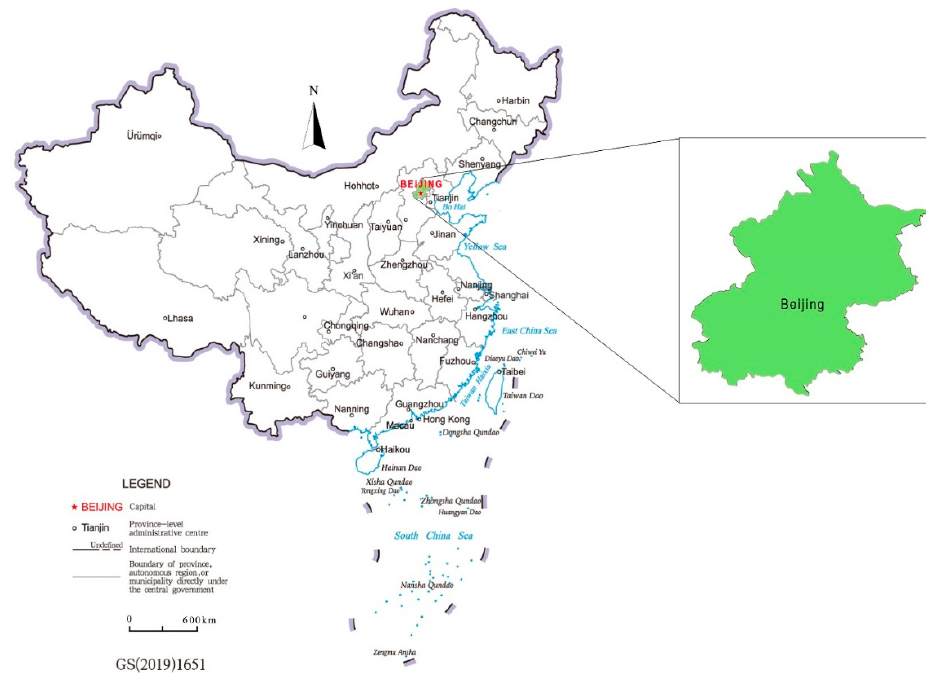
Figure 2. The location of Beijing, China.